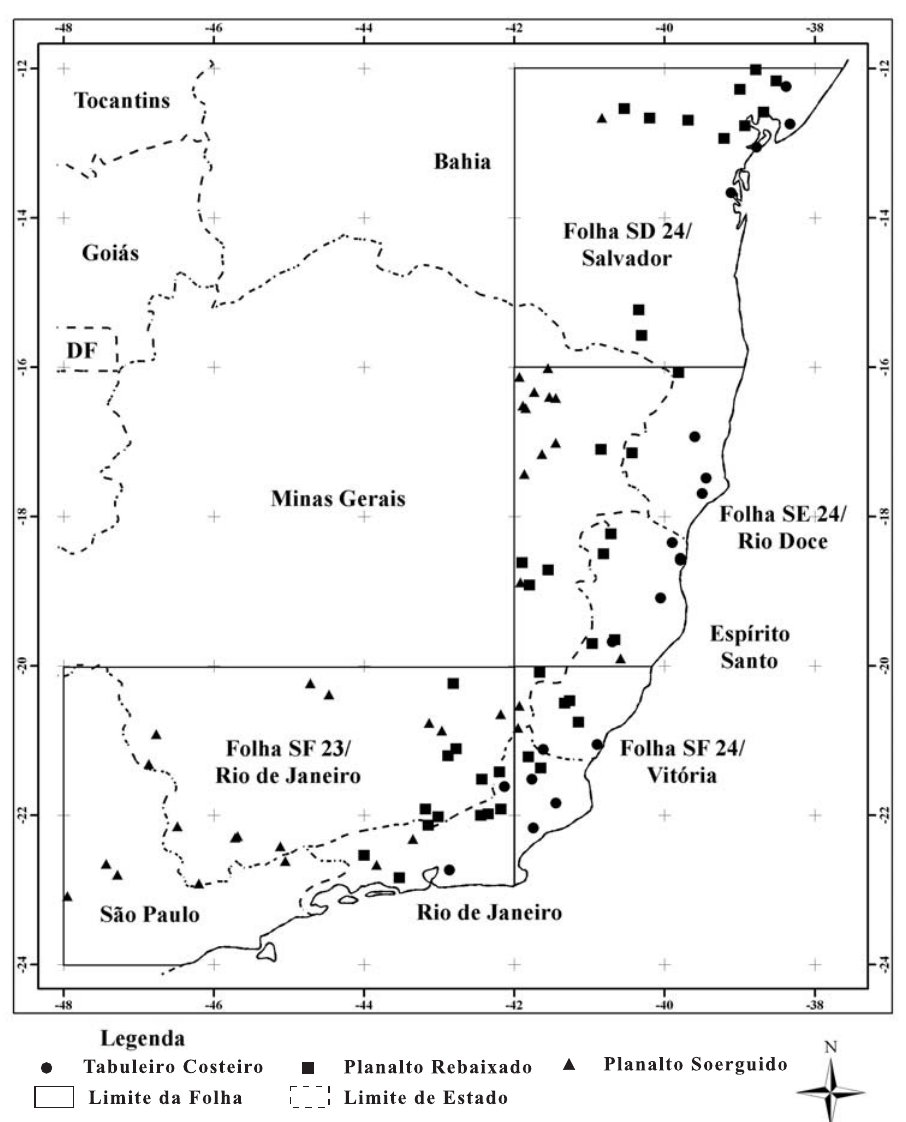
Figura 1. Localização dos perfis estudados nas Folhas do Projeto